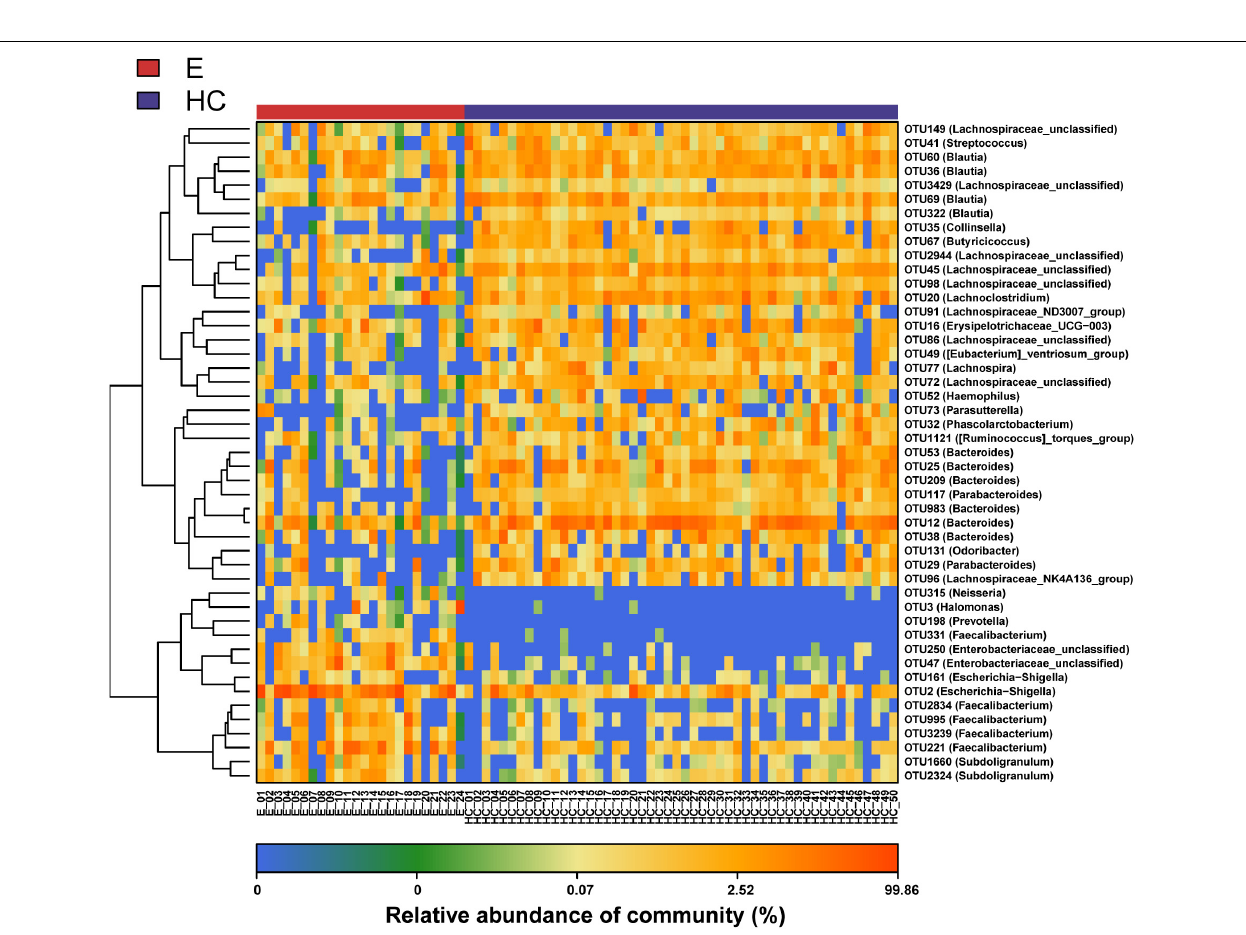
FIGURE 4 | Heat map of the relative abundances of differential OTUs between Eps ( n = 24) and HCs ( n = 50). For each sample, the columns show relative abundance data for differential OTUs on the right. The relative abundance of each OTU was used to plot the heat map (blue, low abundance; red, high abundance). Group data are shown above the plot: HCs, right, blue line; Eps, left, red line. Each row represents one OTU. Eps, patients with epilepsy; HCs, healthy controls; NMDS, nonmetric multidimensional scaling; PCoA, principal coordinate analysis; ANOSIM, analysis of similarities; OTUs, operational taxonomic units.